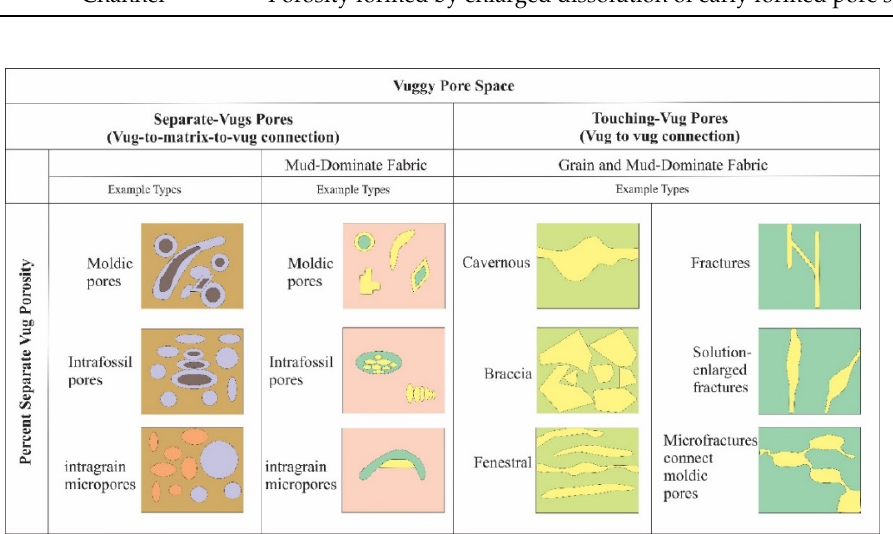
Figure 6. Geological and petrophysical classification of vuggy pore spaces based on vugs intercon- nection, after Lucia [38].